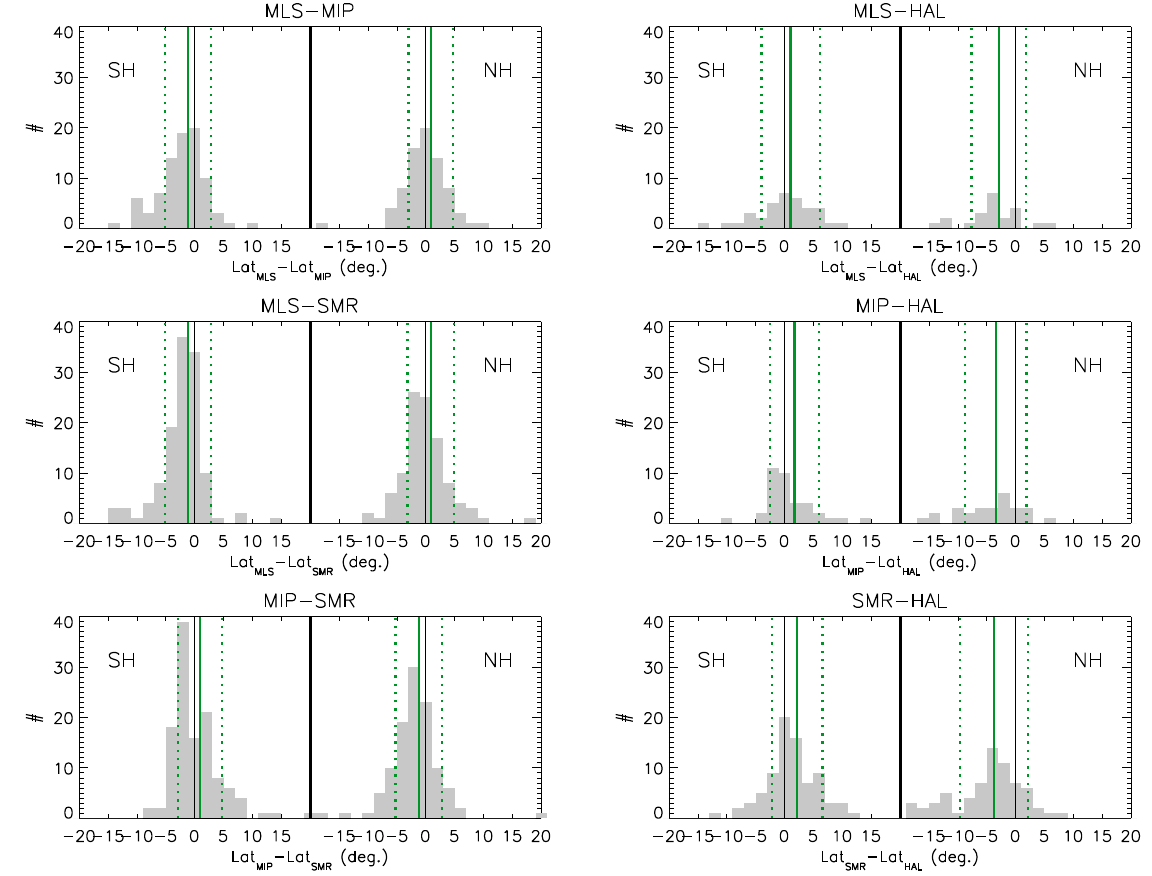
Fig. 5. Histograms of the sensor-to-sensor differences (MLS-MIPAS, MLS-SMR, MIPAS-SMR in the left column and MLS-HALOE, MIPAS-HALOE, SMR-HALOE in the right column) in the subtropical edge position. The mean and standard deviation values of the histogram distributions are shown as the solid and dashed green lines, respectively (see also Table 2). Table 2. Mean and standard deviation values of the histogram distributions of the differences between the barrier latitude calculated from each pair of sensors shown in Fig. 5. Note that the timing of the overlap periods of the different sensor pairs is not identical. MLS-MIP MLS-HAL MLS-SMR MIP-HAL MIP-SMR SMR-HAL NH 45